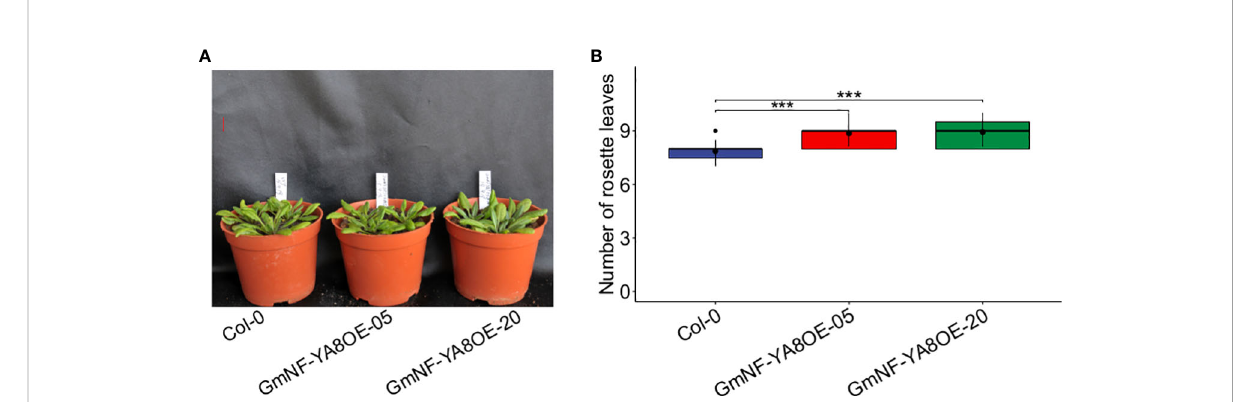
FIGURE 5 Ectopic expression of GmNF-YA8 delays bolting in Arabidopsis (A) Photos were taken when the bolt in 20-day-old Col-0 plants was one-cm high, the transgenic lines had not yet bolted. GmNF-YA8OE-05 and GmNF-YA8OE-20 indicates the transgenic lines that overexpress GmNF- YA8 , respectively. Scale bar, 1 cm. (B) The number of rosettes was counted in each 12 Col-0, GmNF-YA8OE- (B) 05, and GmNF-YA8OE-20 plants respectively, when the bolt was one-cm high. Student ’ s t -test was used to compare the difference between Col-0, GmNF-YA8OE-05 and